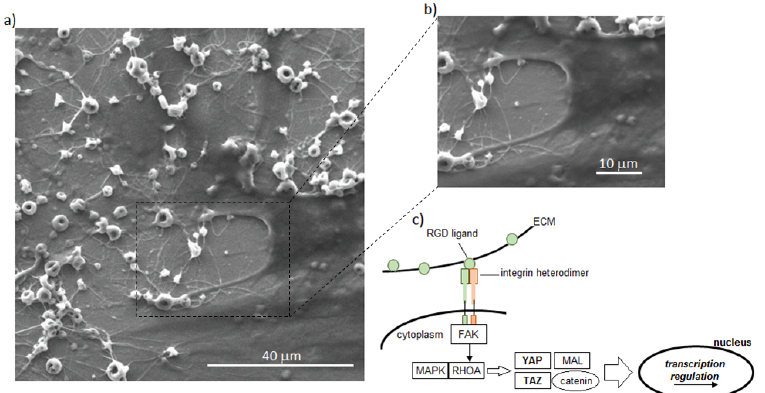
Figure 6. Biomechanical guidance. Keratin nanogrooves and nanofibers were used to drive cells adhesion and spread exploiting their biomechanical guidance towards cytoskeleton ( a , b ). This process involves the activation of di ff erent pathways mainly related to the Yes-associated protein (YAP) / TAZ nuclear signaling ( c ). (Authors’ own